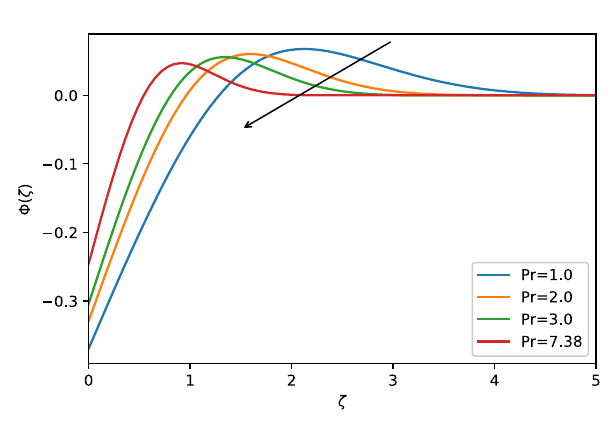
Fig. 14 Φ( 𝜁 ) against A